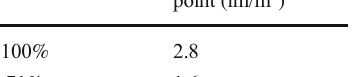
Table 2 Horizontal illumination of the experiment point in different lighting levels